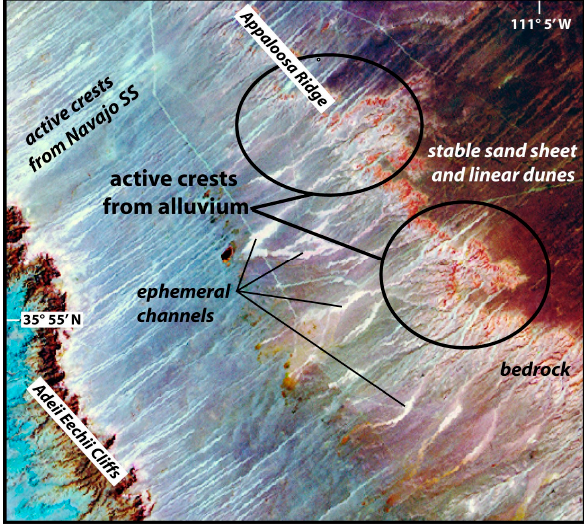
Figure 5. Active linear dune crests on the Moenkopi Plateau are bright in landsat imagery. Some active crests head at the Adeii Eechii Cliffs, others form downwind from alluvial channels and climb onto Appaloosa Ridge. Base imagery is a Landsat scene from June, 2000 in 2-4-7 band combination (RGB). Our examination of the linear dune sediments near the Gold Springs meteorological station revealed that sand on the crest of the linear dune is very similar in grain size, sorting, and rounding to the Navajo Sandstone [19], outcrops of which are heavily fluted along the Adeii Eechii Cliffs. Crest sand samples (1A) have the lowest magnetic susceptibility values, which are most similar to Navajo Sandstone (inset charts in Figure 6), and do not contain the clear red quartz grains common in the other cored units (Table 1). From the first transect to the third, surface crest samples become redder